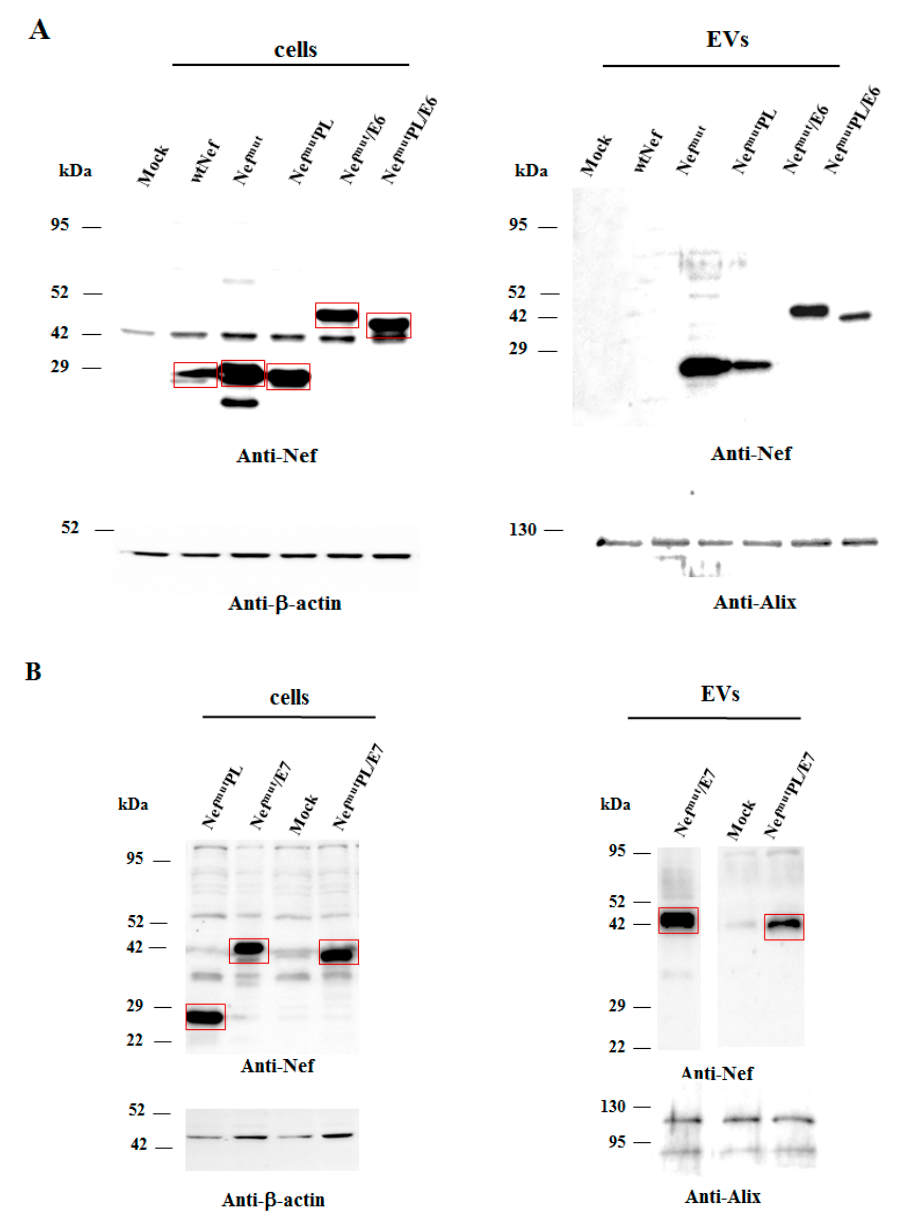
Figure 3. Detection of HPV16-based fusion products in both transfected cells and EVs. ( A ) Western blot analysis on 30 µ g of lysates of HEK293T cells transfected with DNA vectors expressing the indicated fusion products (left panel), and equal volumes of the buffer where purified EVs were resuspended after differential centrifugations of respective supernatants (right panel). As a control, conditions from mock-transfected cells, as well as cells transfected with either wt Nef, Nef mut , or Nef mut PL, were included. The results are representative of three independent experiments. ( B ) Analysis on 30 µ g of lysates of HEK293T cells transfected with DNA vectors expressing the indicated products (left panel), and equal volumes of the buffer where purified EVs were resuspended after differential centrifugations of respective supernatants (right panel). As a control, conditions from mock-transfected cells were included. The results are representative of four independent